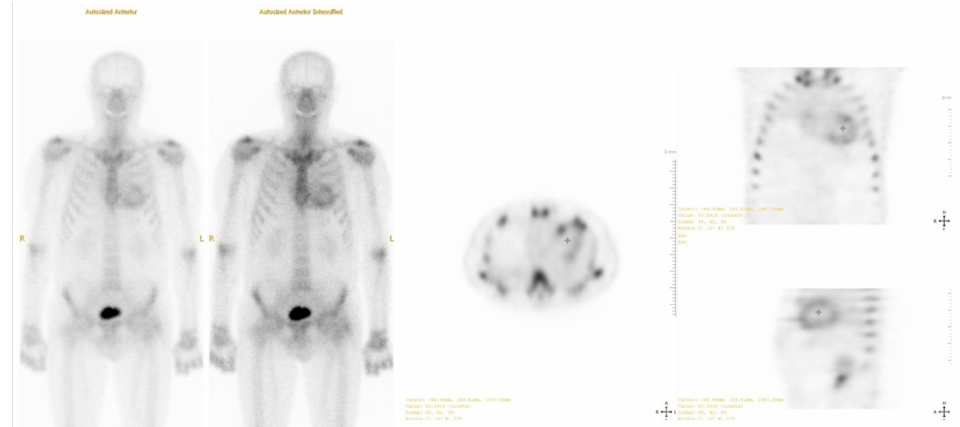
Figure 5. Technetium-99 m pyrophosphate single photon emission computed tomography (SPECT): positive uptake of radiotracer in the heart 1 h after injection (Grade